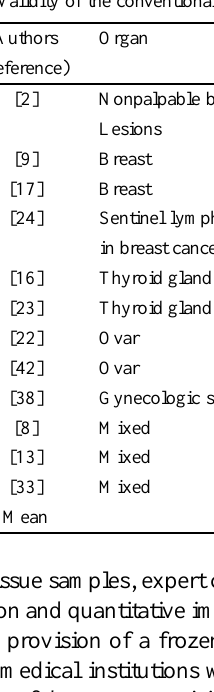
Validity of the conventional frozen section diagnosis with respect to different